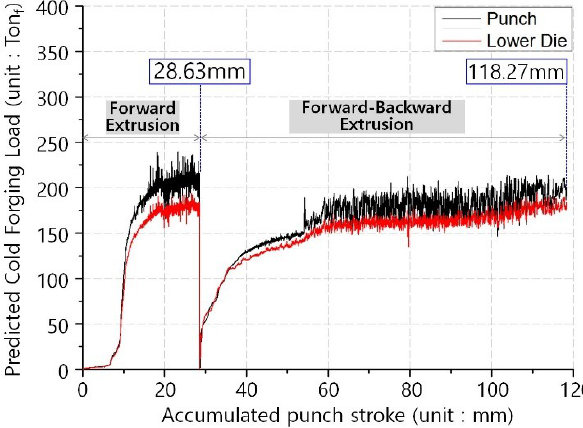
Figure 9. Load prediction of two-stage cold forging sequence for fabricating the drive shaft.